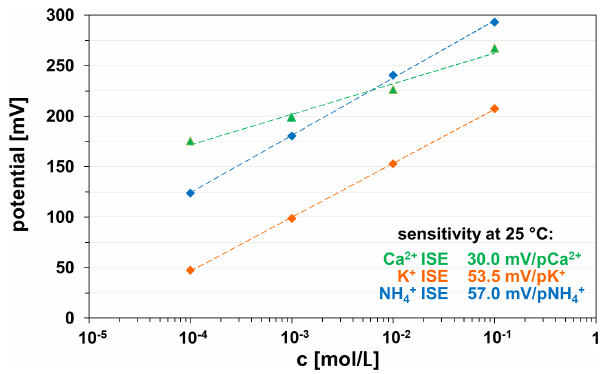
+ , and Ca 2 + ) in the 4